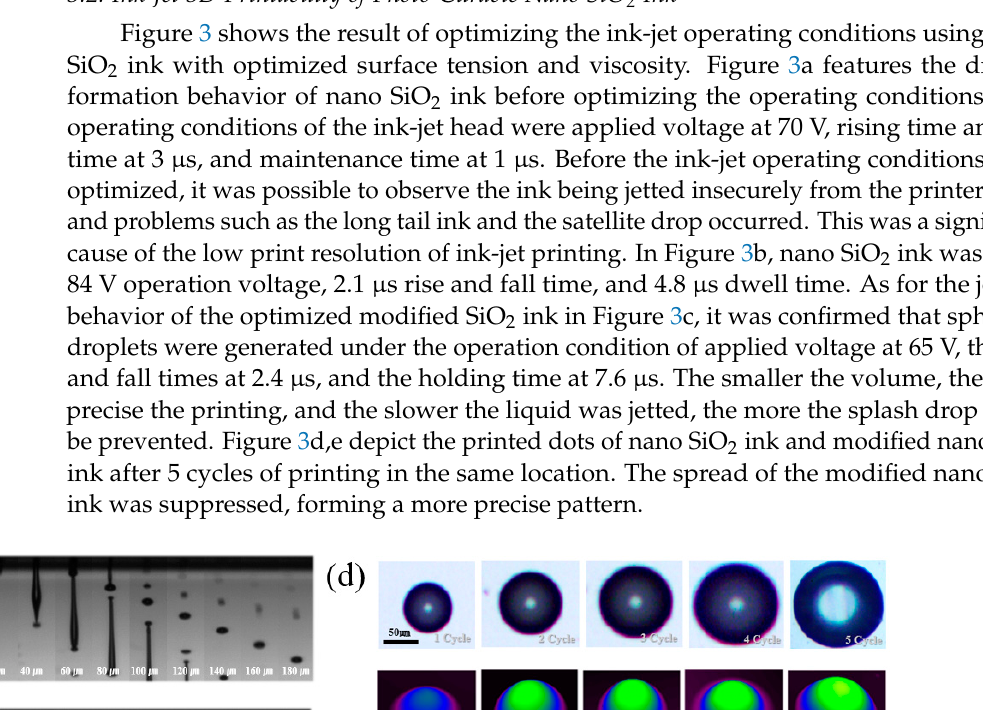
Table 1. Rheological properties of photo-curable nano SiO 2 ink and modified nano SiO 2 ink.